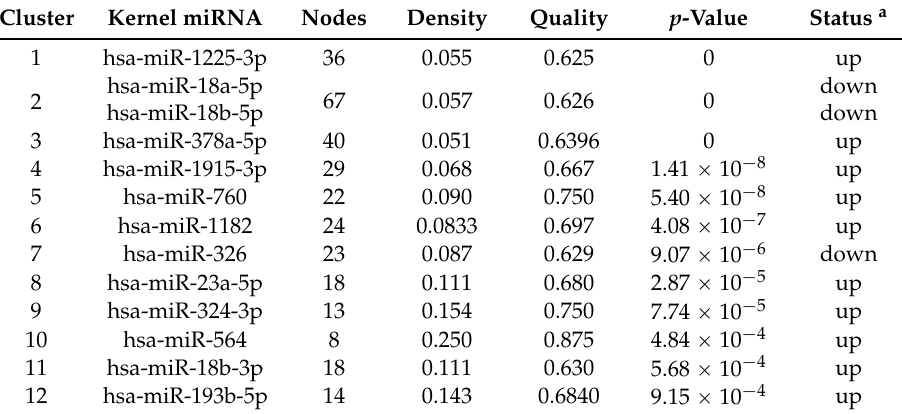
Table 1. The distribution of potential miRNA markers from the